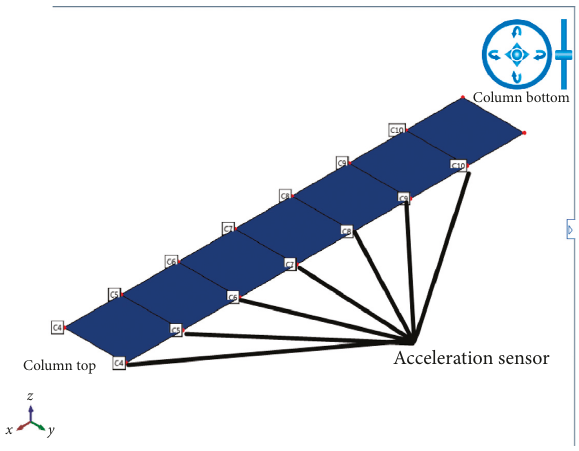
Figure 9: Analysis